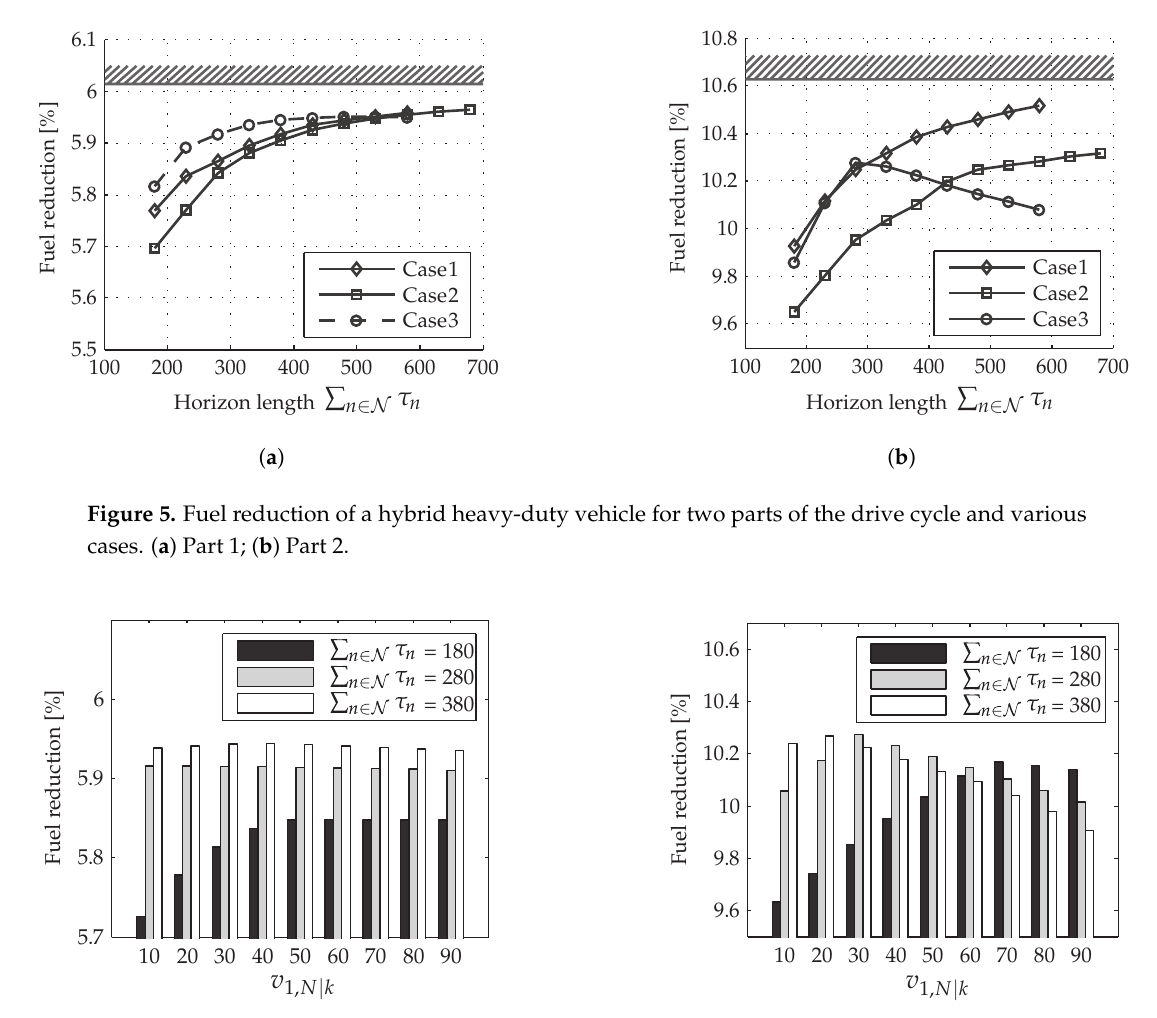
Figure 6. Sensitivity to the pre-specified value of v 1,